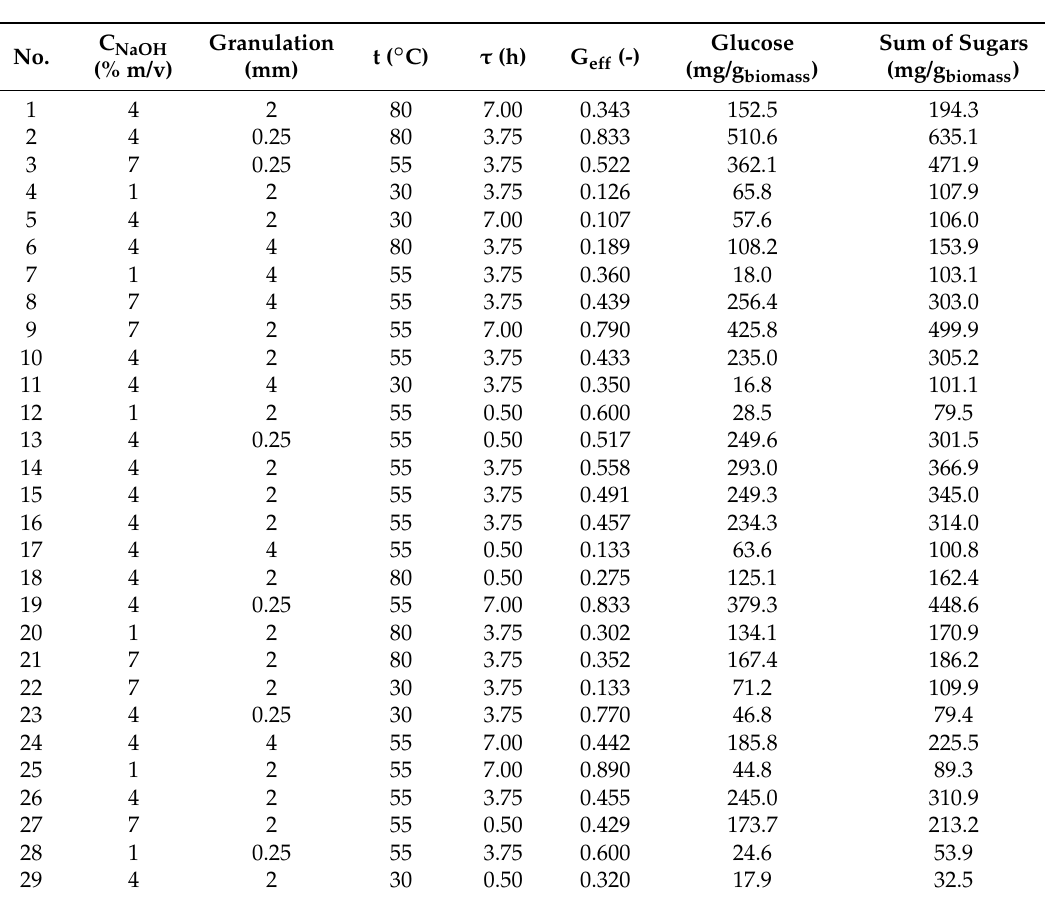
Table 5. Box-Behnken experimental design for two-step hydrolysis of Salix Viminalis